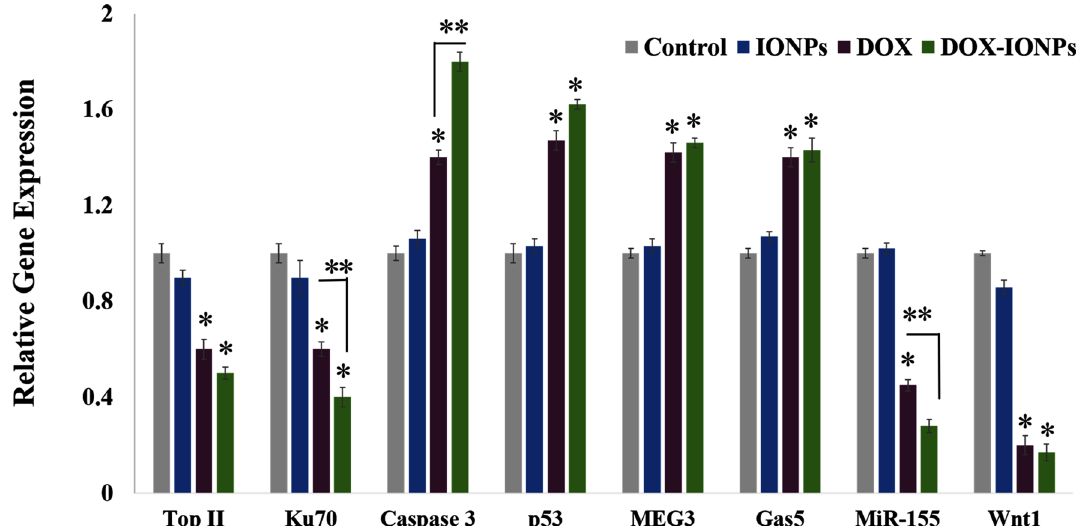
Figure 10. Relative gene expression of U251 cell upon treatment with either EDT-IONPs, DOX or DOX- EDT-IONPs for 48 h. *Indicates a significant difference compared to the control group, and **compared to DOX-treated cells at p < 0.05. Data is presented as mean ± S.D, and n = 5. IONPs and DOX-IONPs represent for EDT-IONPs and